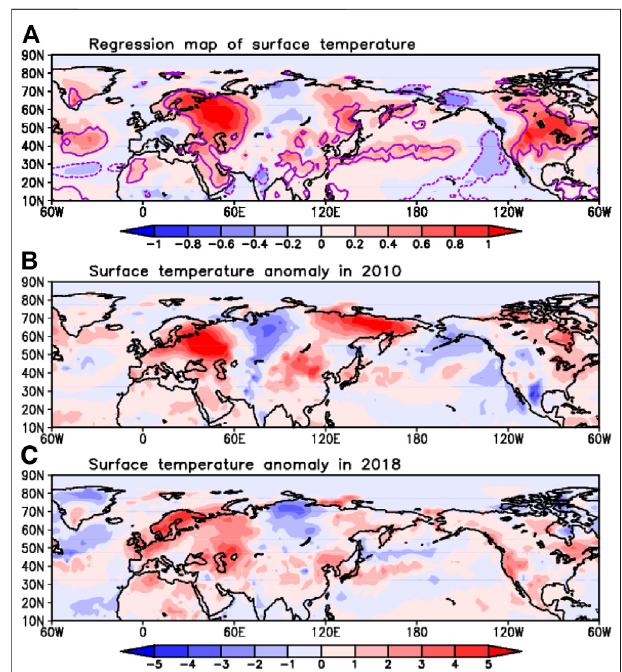
FIGURE 2 | (A) The surface temperature regression map (shading) in JulyagainstthePC, (B) 2010,and (C) 2018anomalypattern. Purplecontours show 95% signi fi cant